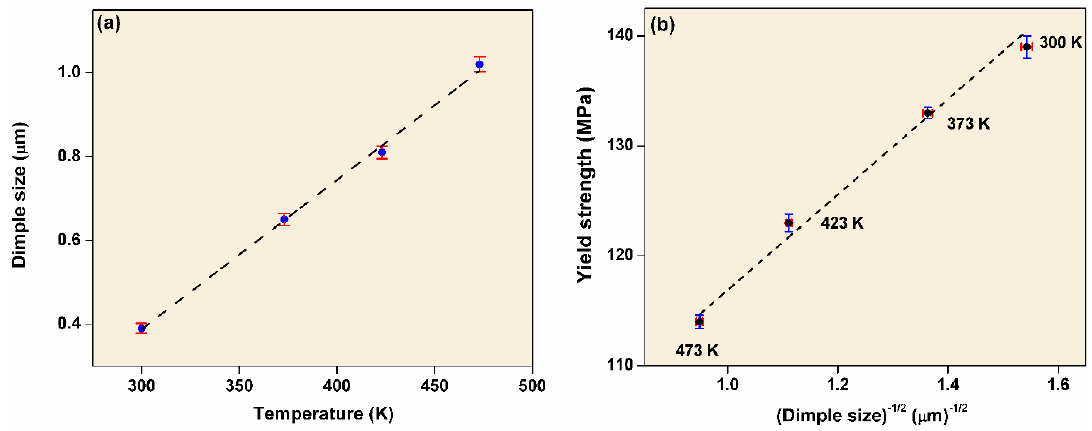
Figure 5. ( a ) Variation of dimple size as a function of the tensile test temperature; ( b ) yield strength vs. dimple size for the SLM-fabricated Al-12Si samples.